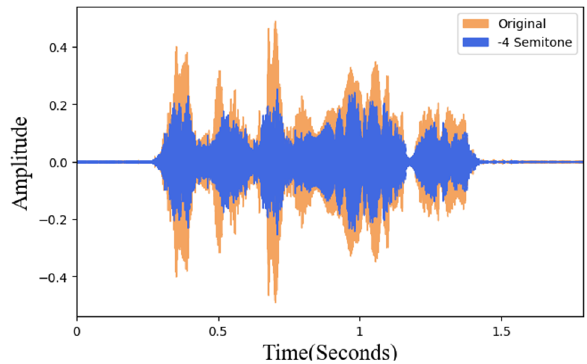
Figure 7. Pitch adjustment and original data waveform.